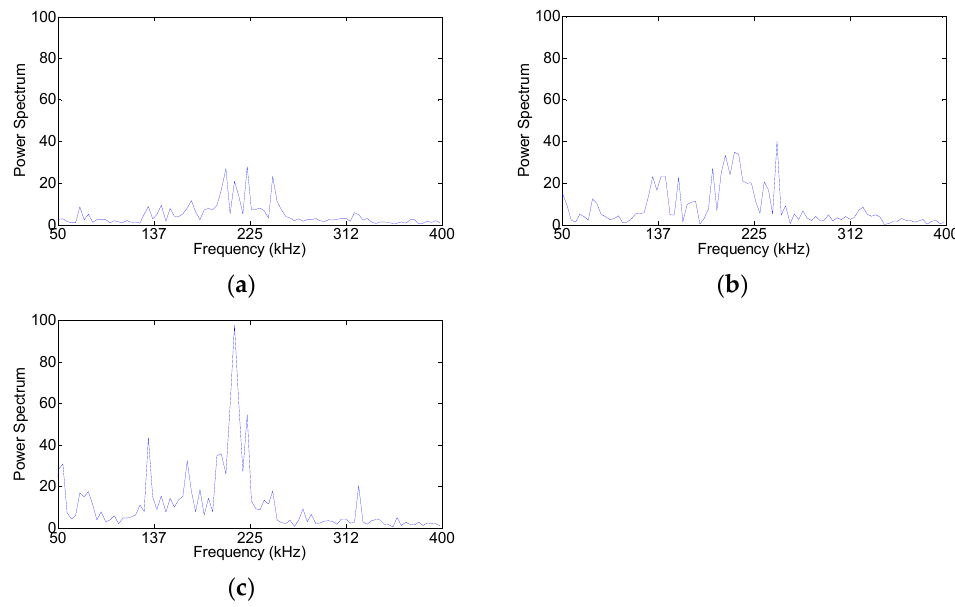
Figure 10. Spindle AE signals: ( a ) span a; ( b ) span b; ( c ) span c.